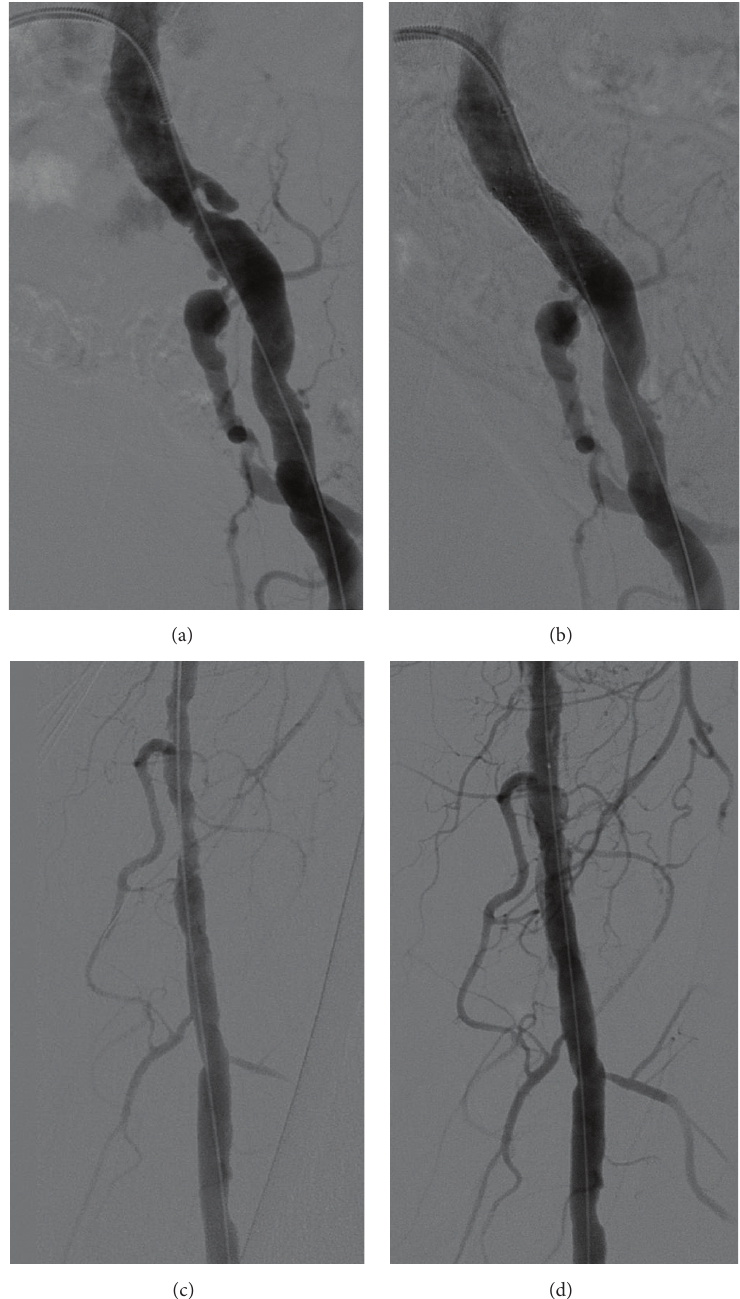
Figure 1: Left common iliac artery before (a) and after (b) percutaneous transluminal angioplasty and placement of one bare metal stent. Left superficial femoral artery before (c) and after (d) percutaneous transluminal angioplasty with a drug eluting